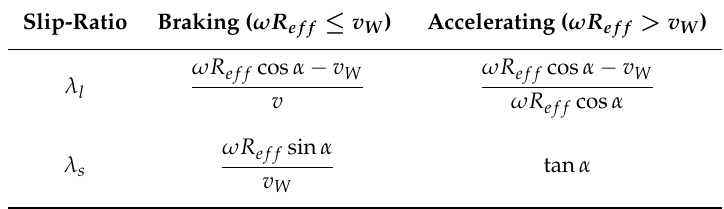
Table 2. Longitudinal and lateral slip-ratio with respect to states of the vehicle.